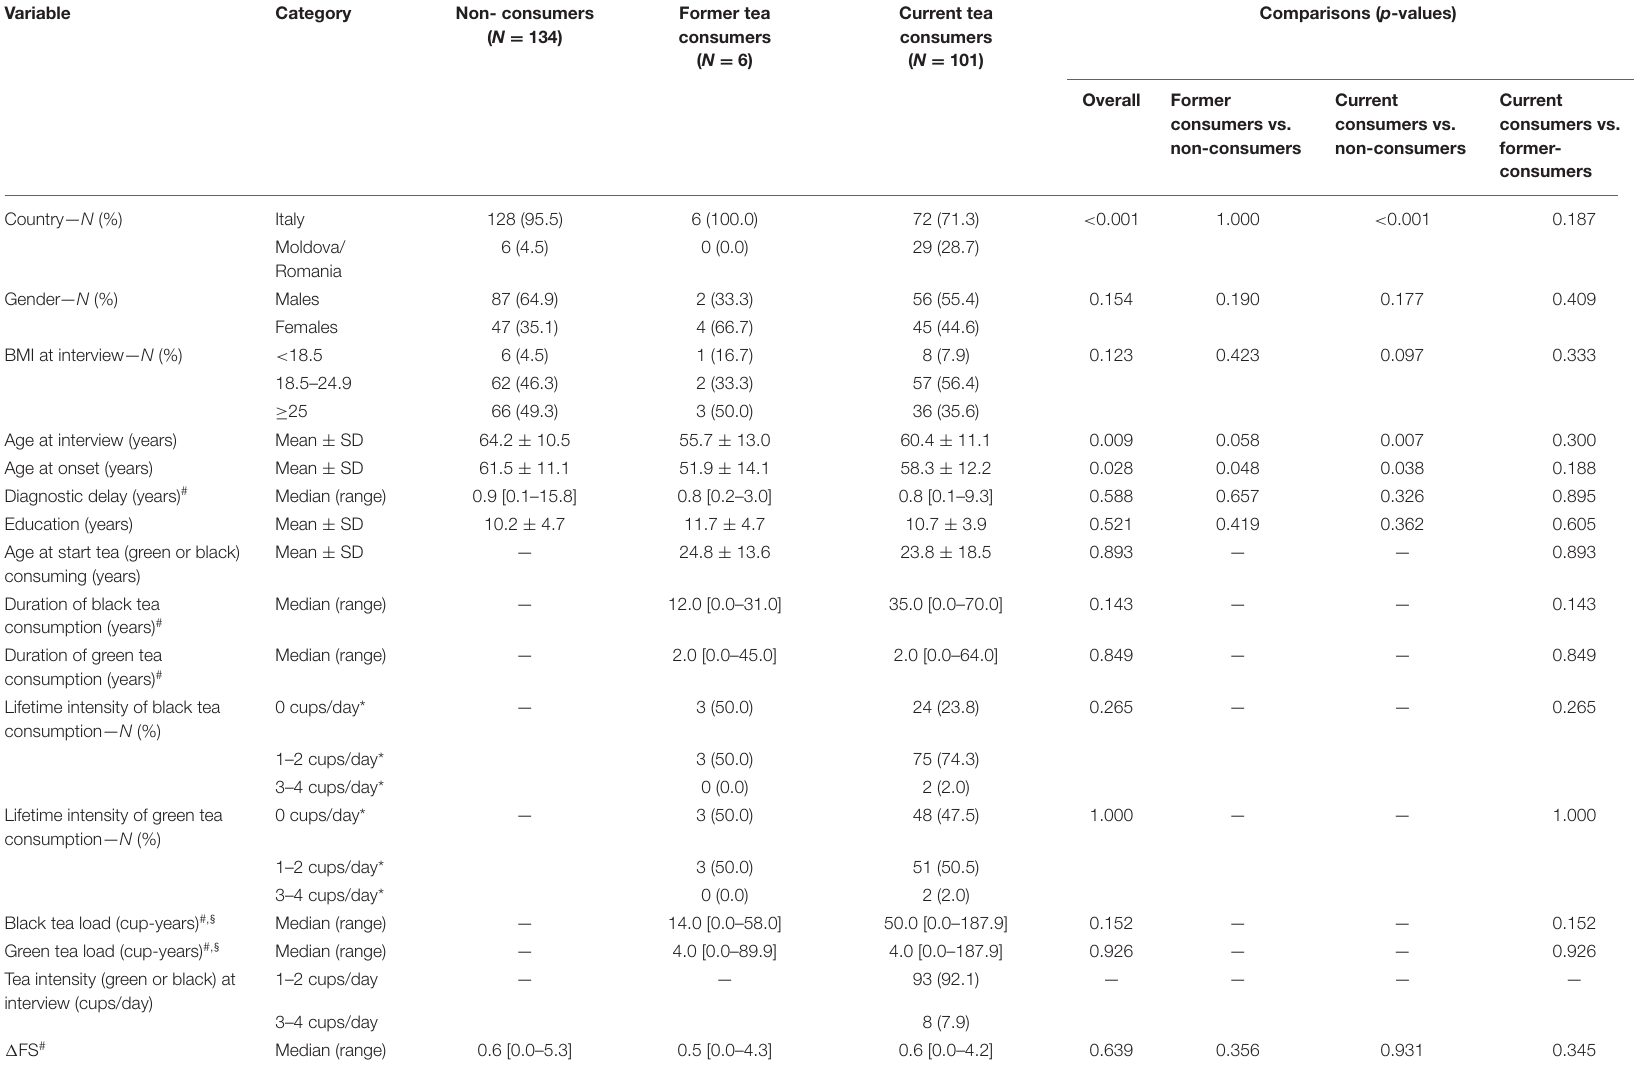
TABLE 3 | Clinical variables according to tea consumption status (i.e., none vs. former vs. current consumers).